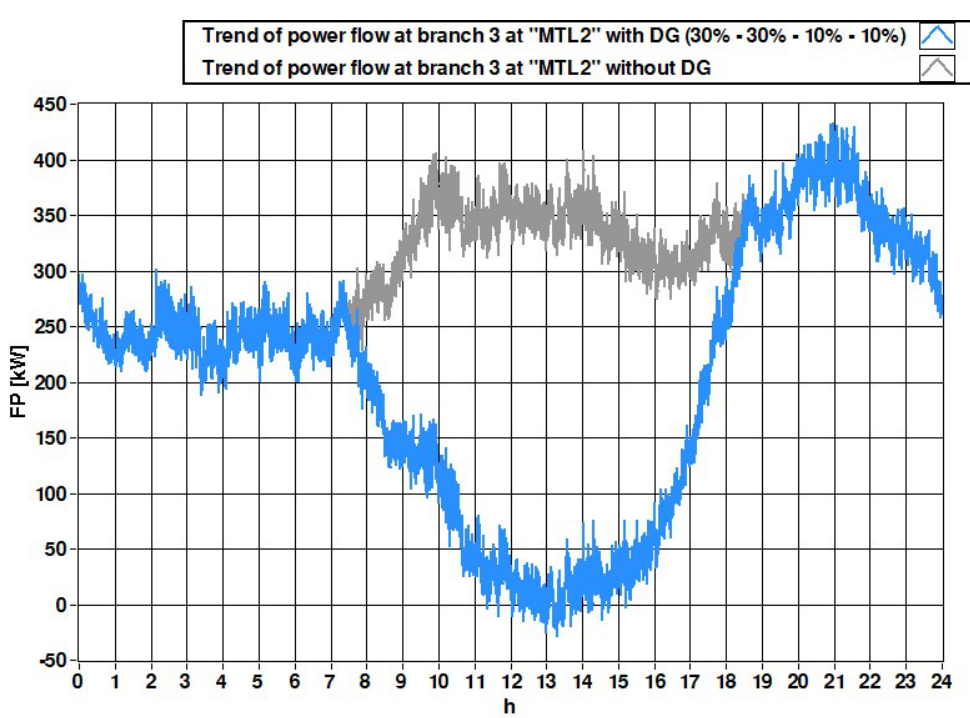
Figure 27. Active power flow during the day 31 May 2018 in branch 3 of the “MTL2” line, both in the absence and with the DG power injection corresponding to Scenario 4.